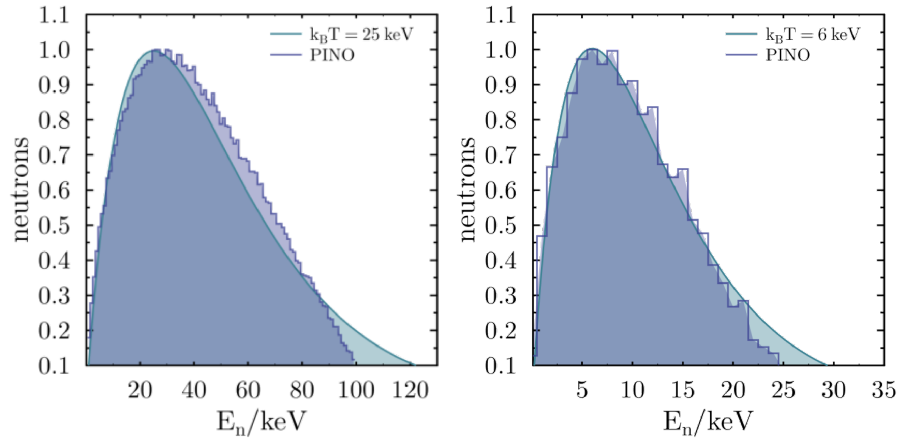
Figure 2. PINO-Simulation for neutrons passing the sample placed 3.2mm after the lithium target (blue) compared with a Maxwellian distribution (green). Left: k B T = 25keV, disk-shaped sample with 10mm radius, E proton = 1912 keV. Right: k B T = 6keV, ring-shaped sample with an inner radius of 6 mm and outer radius of 10 mm, E proton = 1914 keV.